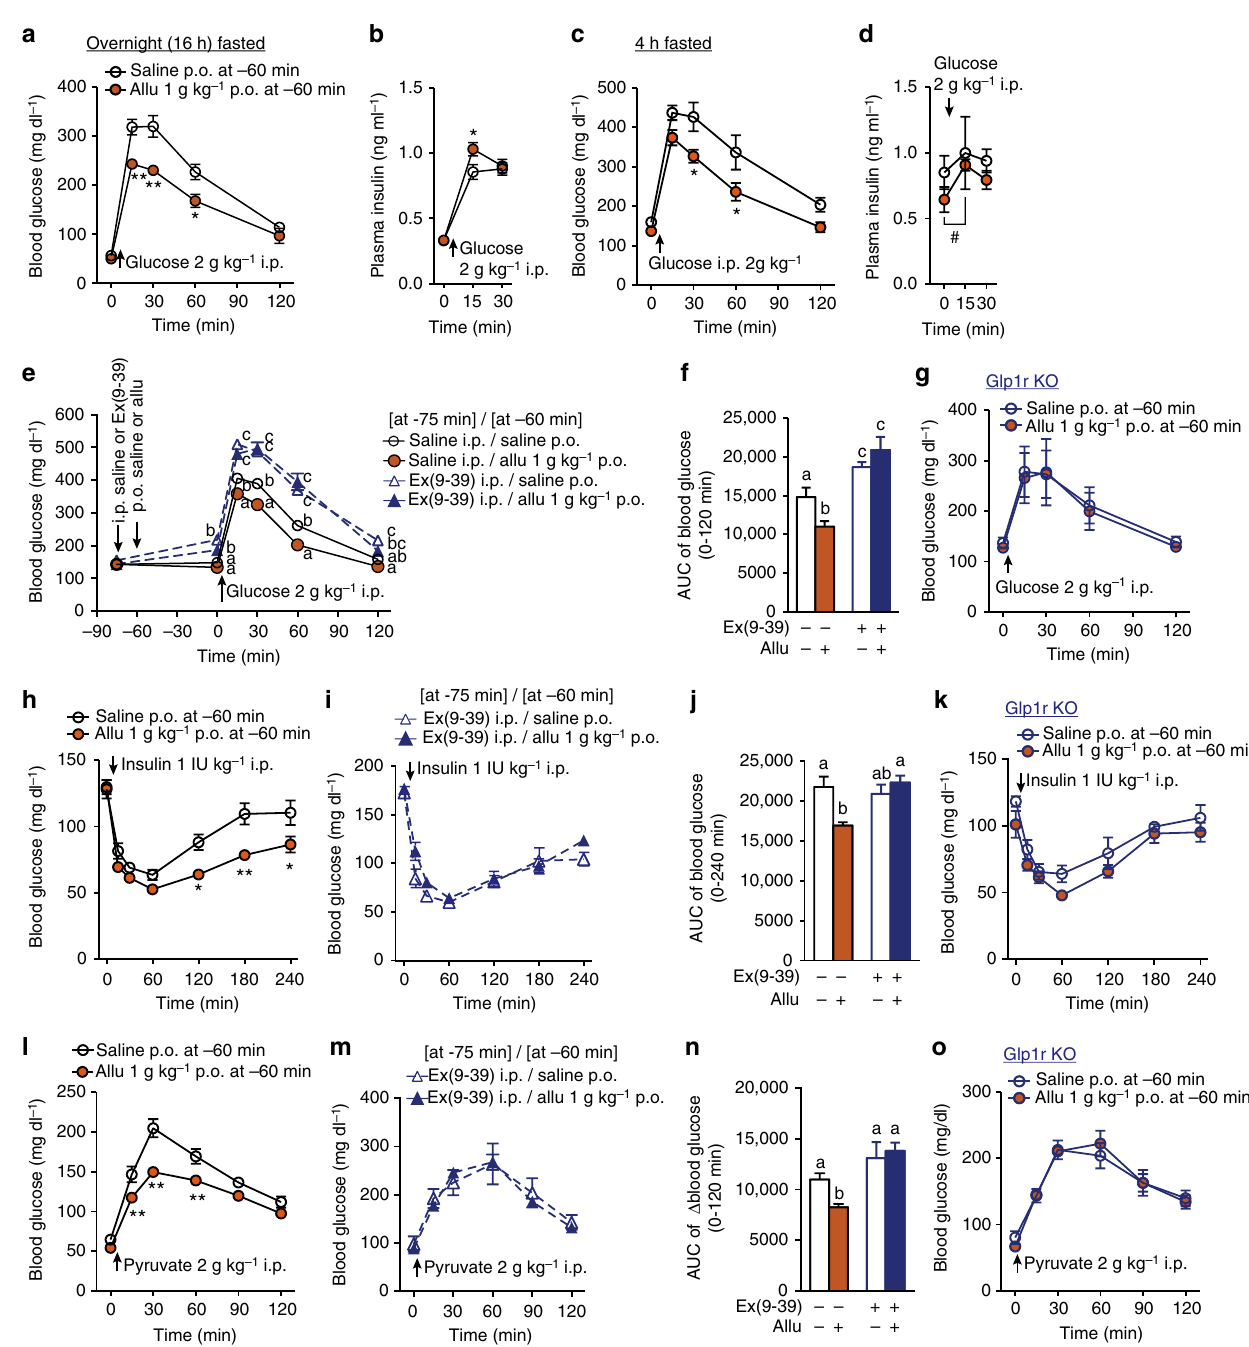
Fig. 3 D -Allulose improves glucose tolerance via GLP-1R signaling. Allu at 1 g kg − 1 was p.o. administered at 60 min prior to ipGTT (2 g kg − 1 ), a – g ,